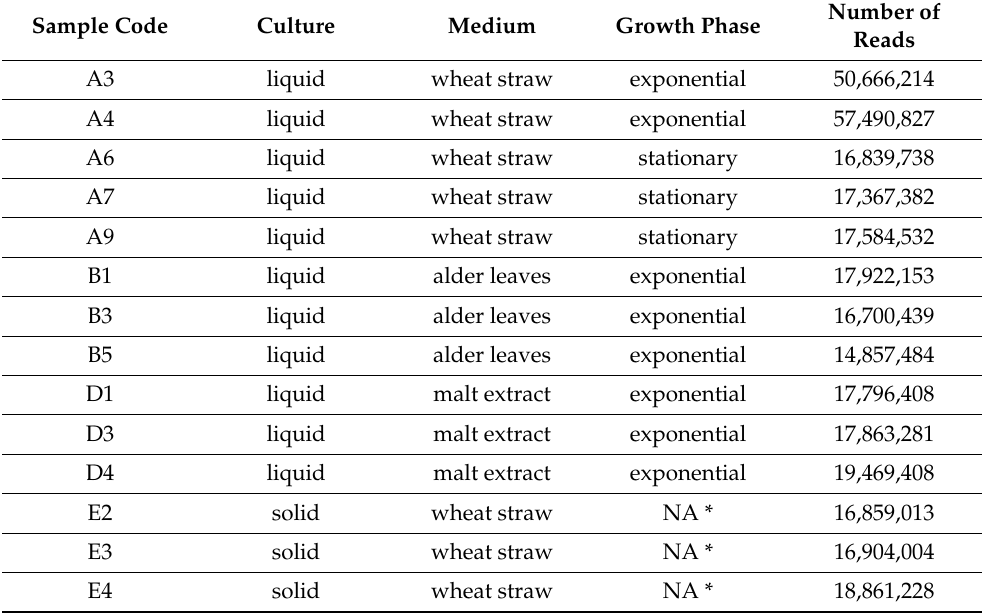
Table 1. C. aquatica samples grown under different conditions.